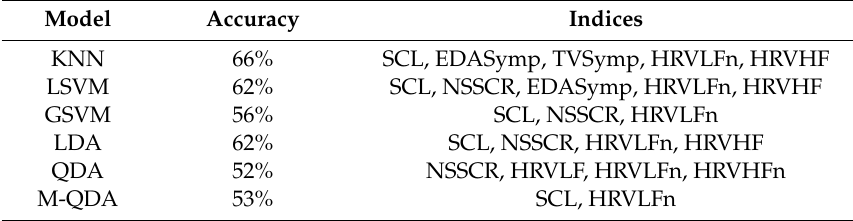
Table 2. Maximum leave-one-subject-out cross-validation accuracy for each task-classification machine learning